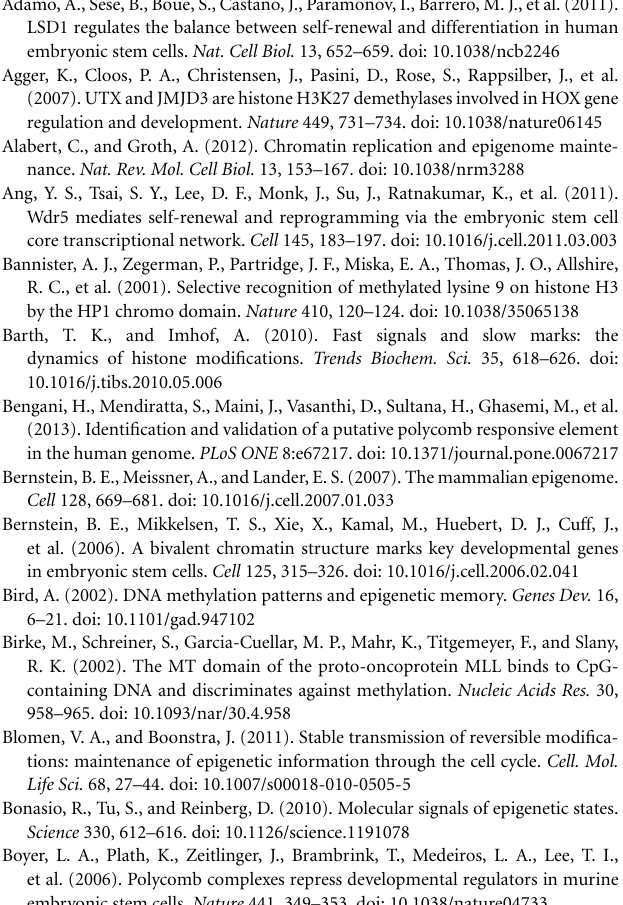
Supplemental Table 1 | Function of histone methyltransferases and demethylases involved in epigenetic inheritance during development and ES cell